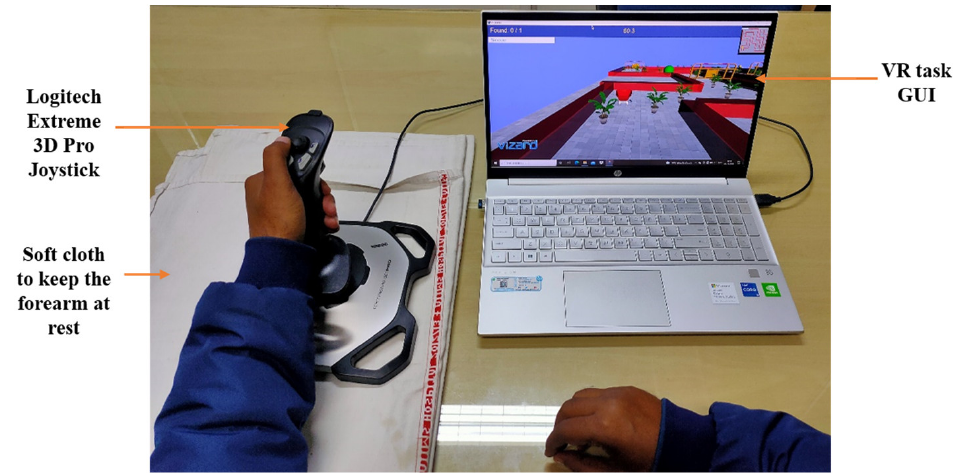
Figure 2. VR therapy setup.